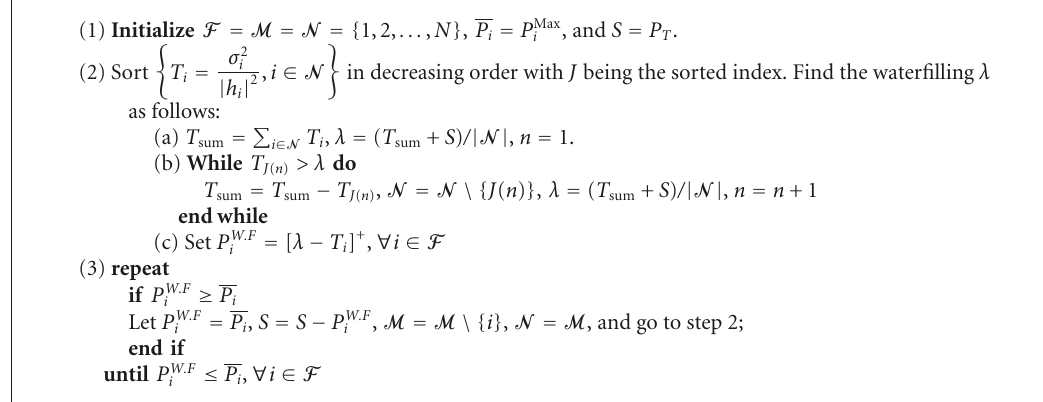
Algorithm 2: Cap-limited waterfilling.